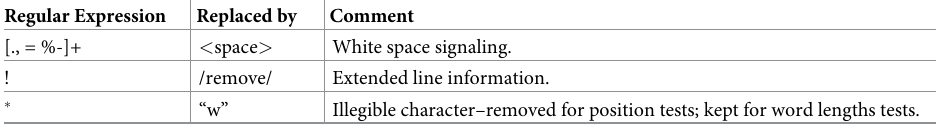
Table 1. Text preprocessing table for the Takeshi Takahashi’s transliteration of the Voynich manuscript. Regular Expression Replaced by Comment [., = %-]+ < space > White space signaling. ! /remove/ Extended line information. � “w” Illegible character–removed for position tests; kept for word lengths tests. Symbols “!”, “ � ”, “-” were tested and included in both remove or space groups without any important impact on further